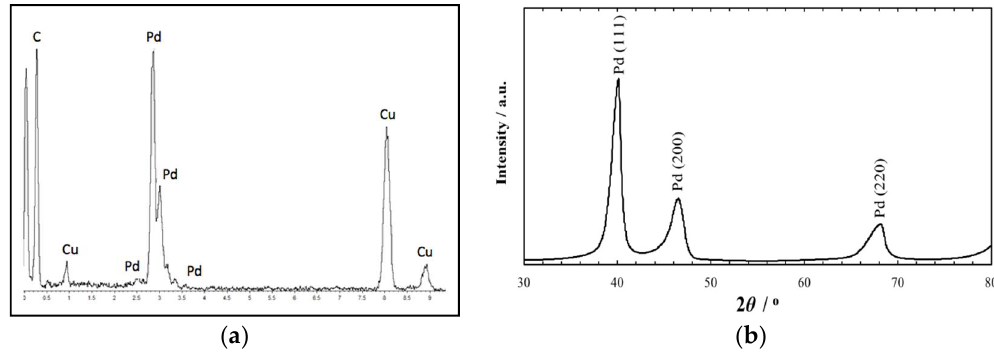
Figure 2. ( a ) EDS spectrum and ( b ) XRD pattern of Pd catalyst.